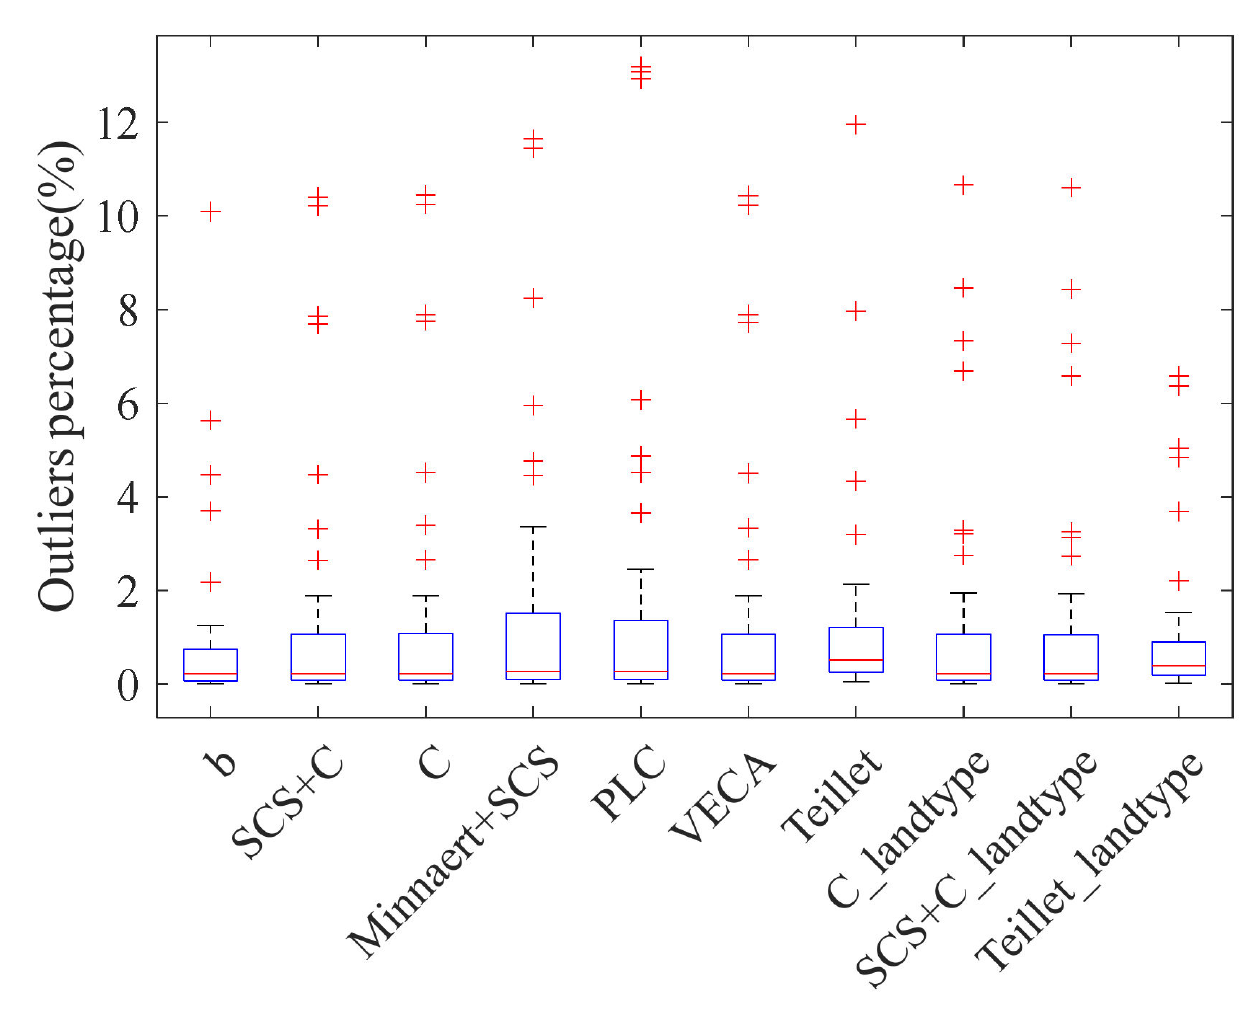
Figure 4. The box plot of all topographic correction models’ outlier percentages (‘_landtype’ refers to the results using the land type stratification